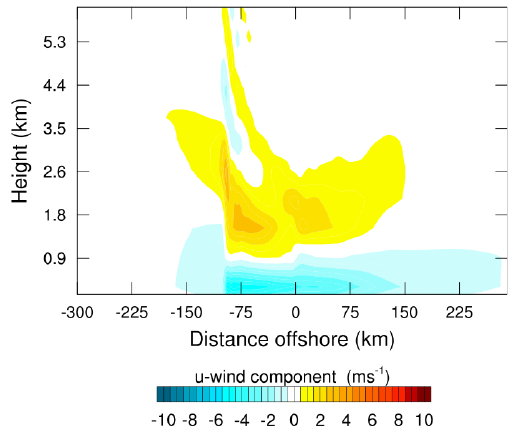
Fig. 16. Cross-section of a backdoor type sea breeze at 19:00UTC generated with shore-parallel gradient winds of − 2ms − 1 for the single coast case. The YSU PBL scheme was used in conjunction with a SST of 287K.